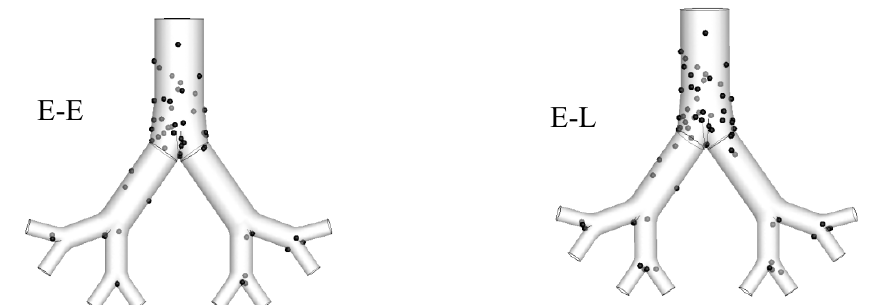
Figure 5. Deposition pattern comparison of 50 nm diameter particle at 25 lpm flow rate. For E-E ( left ) and E-L ( right ) approach.